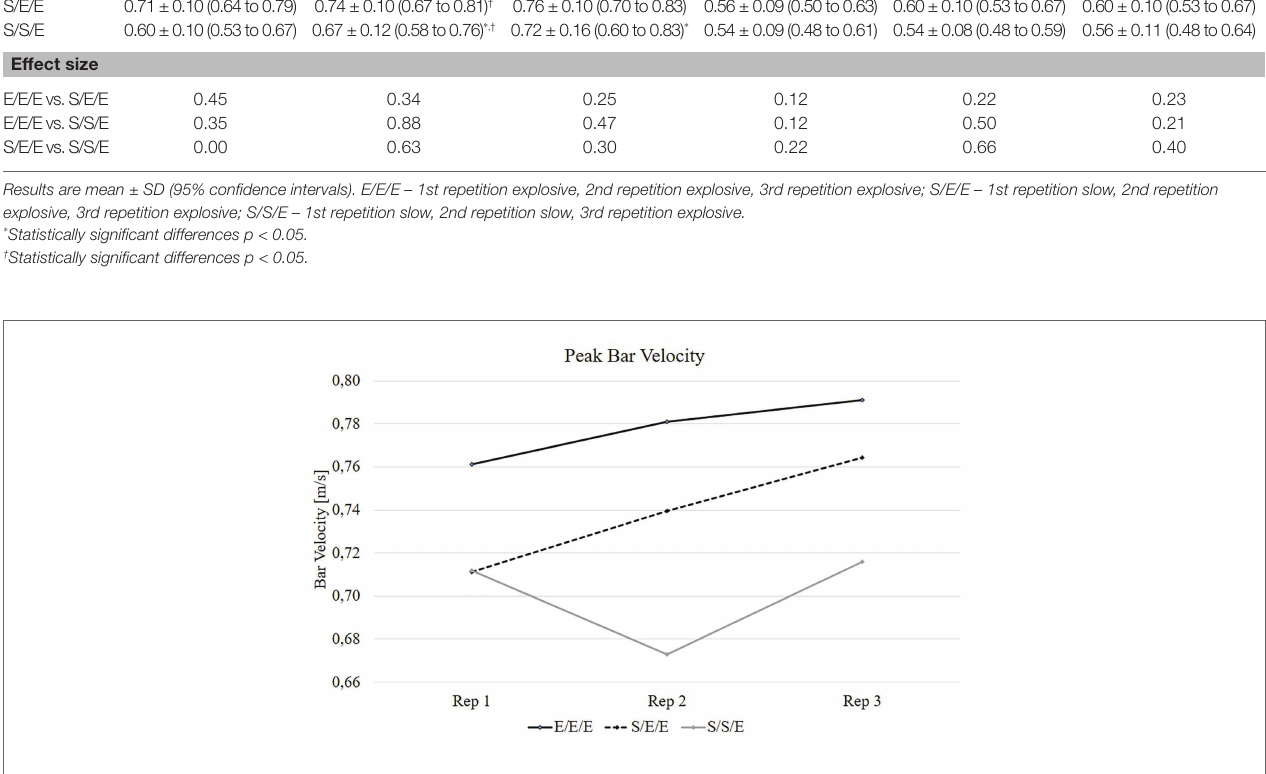
TABLE 2 | A comparison of the three experimental movement tempos in bar velocity variables. Peak bar output Mean bar output Condition 1st 2nd 3rd